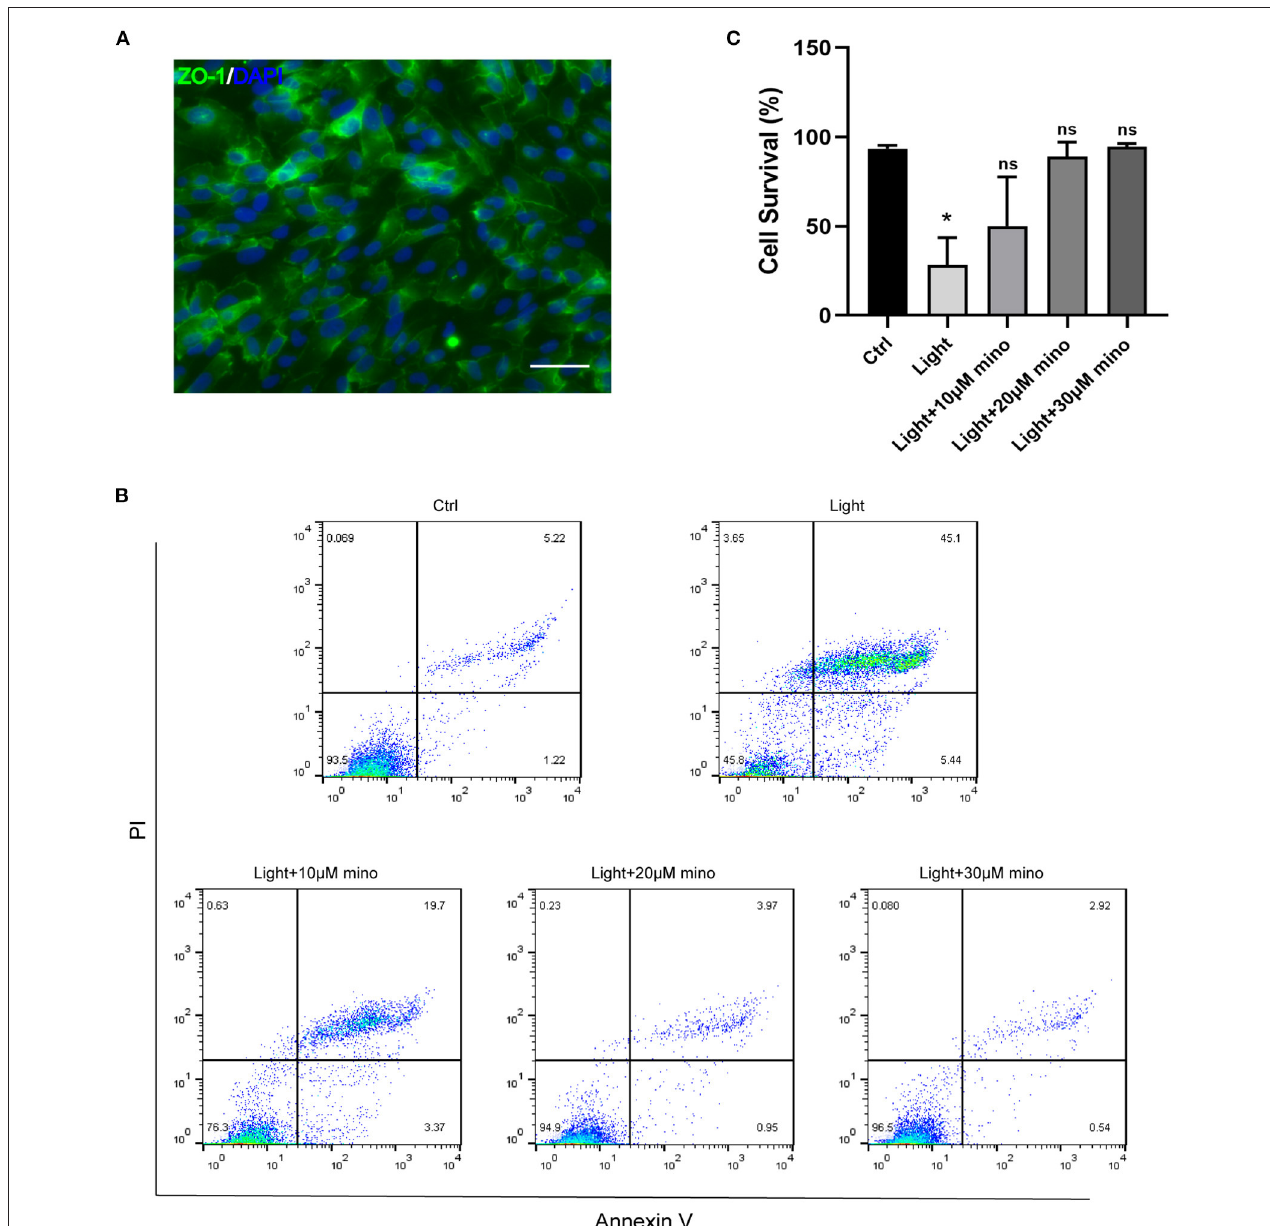
FIGURE 1 | Blue light causes death of RPE cells, and minocycline protects RPE cells from blue light-induced death. (A) ZO-1 immunofluorescence staining of ARPE-19 cells indicated formation of tight junctions. Scale bar: 50 µ m. (B) Detection of ARPE-19 cell viability with Annexin V/PI. With increasing minocycline doses, death of ARPE-19 cells induced by blue light decreased significantly. ARPE-19 cells received blue light exposure for 2h and were further cultured for 2h before Annexin V/PI detection. (C) Quantitative analysis of (B) ( n = 3). * p < 0.05.